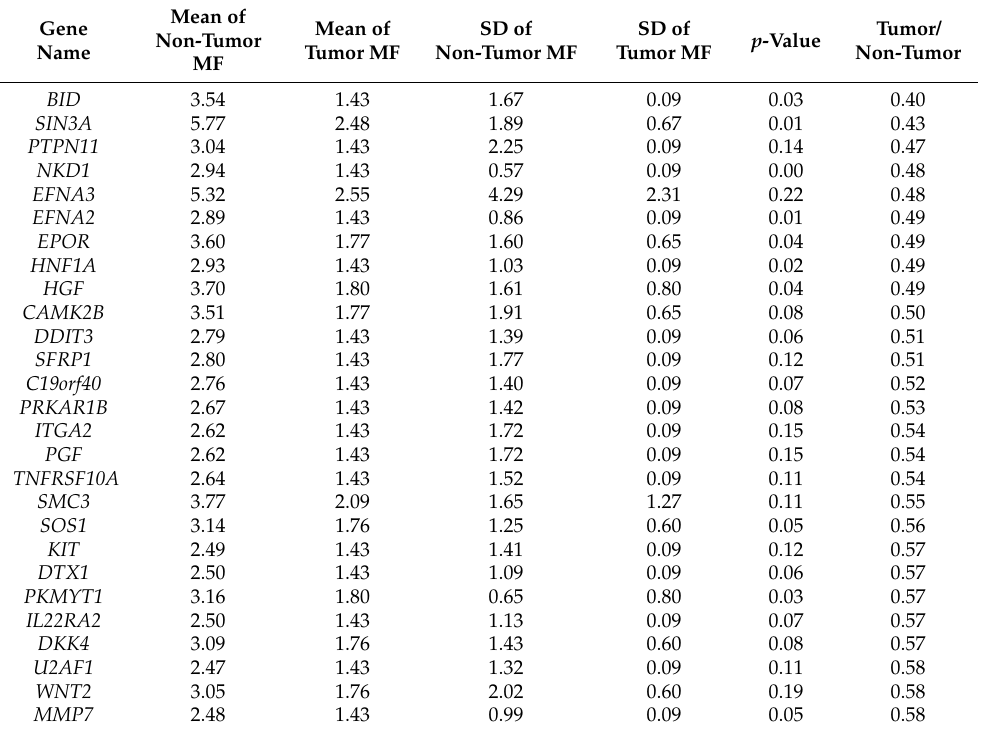
Table 2. Summary of the 30 genes most downregulated in tumor MF based on the tumor/non-tumor MF